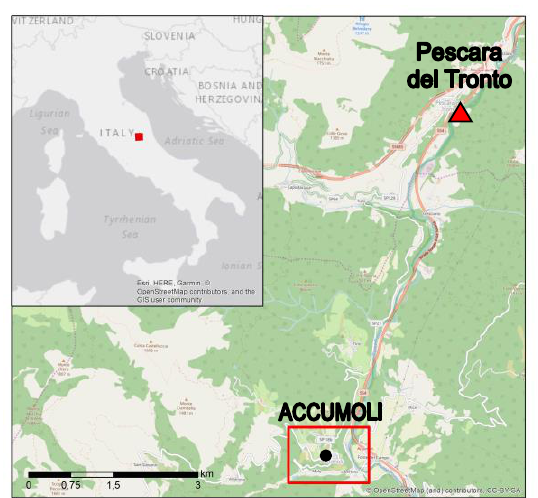
Figure 1. Earthquakes in the last 90 days before the 30 Oct 2016 event (Source: INGV 1 ). Symbol size is proportional to the event magnitude. The symbol color (red = 1 hour; orange = 24 hours; yellow = 72 hours; blue = previous 90 days) identifies the time of occurrence of the earthquakes with respect to the 30 Oct 2016 event (white star).